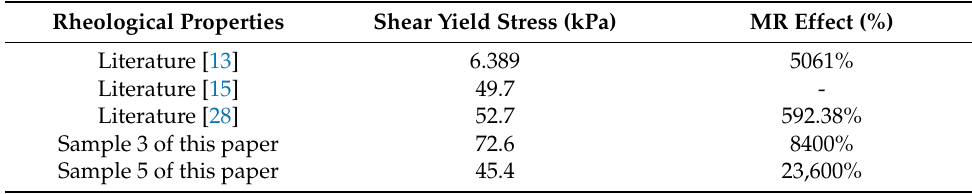
Table 4. Comparison of rheological properties with other MR